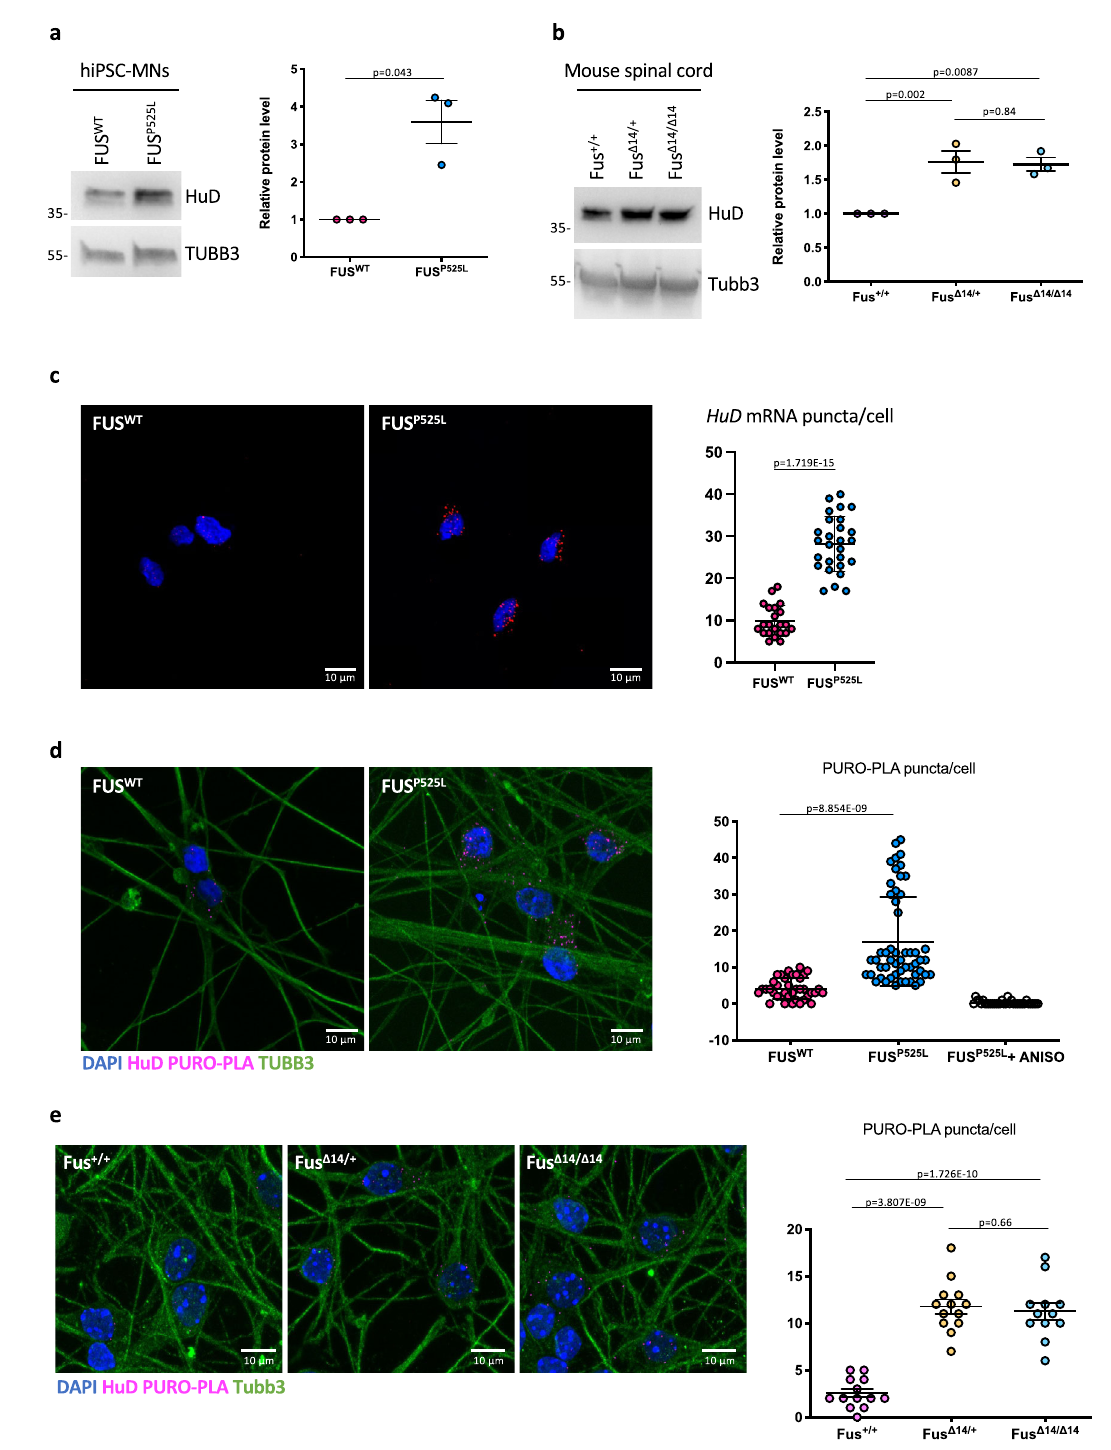
Fig. 1 Increased HuD levels in human and mouse FUS-mutant MNs. a , b HuD protein levels analysis by western blot in FUS WT and FUS P525L hiPSC- derived spinal MNs ( a ) and Fus- Δ 14 mouse model spinal cord (P81) ( b ). The molecular weight (kDa) is indicated on the left. The graphs show the average from three independent biological replicates, error bars indicate the standard deviation ( a Student ’ s t -test, paired, two tails; b ordinary one-way ANOVA, multiple comparisons). TUBB3/Tubb3 signal was used for normalization. Protein levels are relative to FUS WT ( a ) or Fus + / + ( b ) conditions. c HuD mRNA analysis by FISH in FUS WT and FUS P525L hiPSC-derived spinal MNs. The graphs show the average count of HuD mRNA puncta per cell from three independent differentiation experiments, error bars indicate the standard error of the mean (Student ’ s t -test; paired; two tails). d , e Combined PURO-PLA (HuD, magenta) and immunostaining (TUBB3, green) analysis in FUS WT and FUS P525L hiPSC-derived spinal MNs ( d ) and primary MNs from Fus- Δ 14 mouse embryos (E12.5 – 13.5) ( e ). DAPI (blue) was used for nuclear staining. d FUS P525L hiPSC-derived spinal MNs treated with the eukaryotic protein synthesis inhibitor anisomycin (ANISO) were used as negative control of the PURO-PLA. The graphs show the average count of HuD PURO-PLA puncta per cell from three independent differentiation experiments ( d ) and three samples ( e ), error bars indicate the standard error of the mean ( d Student ’ s t - test, unpaired, two tails; e ordinary one-way ANOVA, multiple comparisons). Scale bars ( c – e ): 10 μ m. COMMUNICATIONS BIOLOGY| (2021) 4:1025 |https://doi.org/10.1038/s42003-021-02538-8|www.nature.com/commsbio